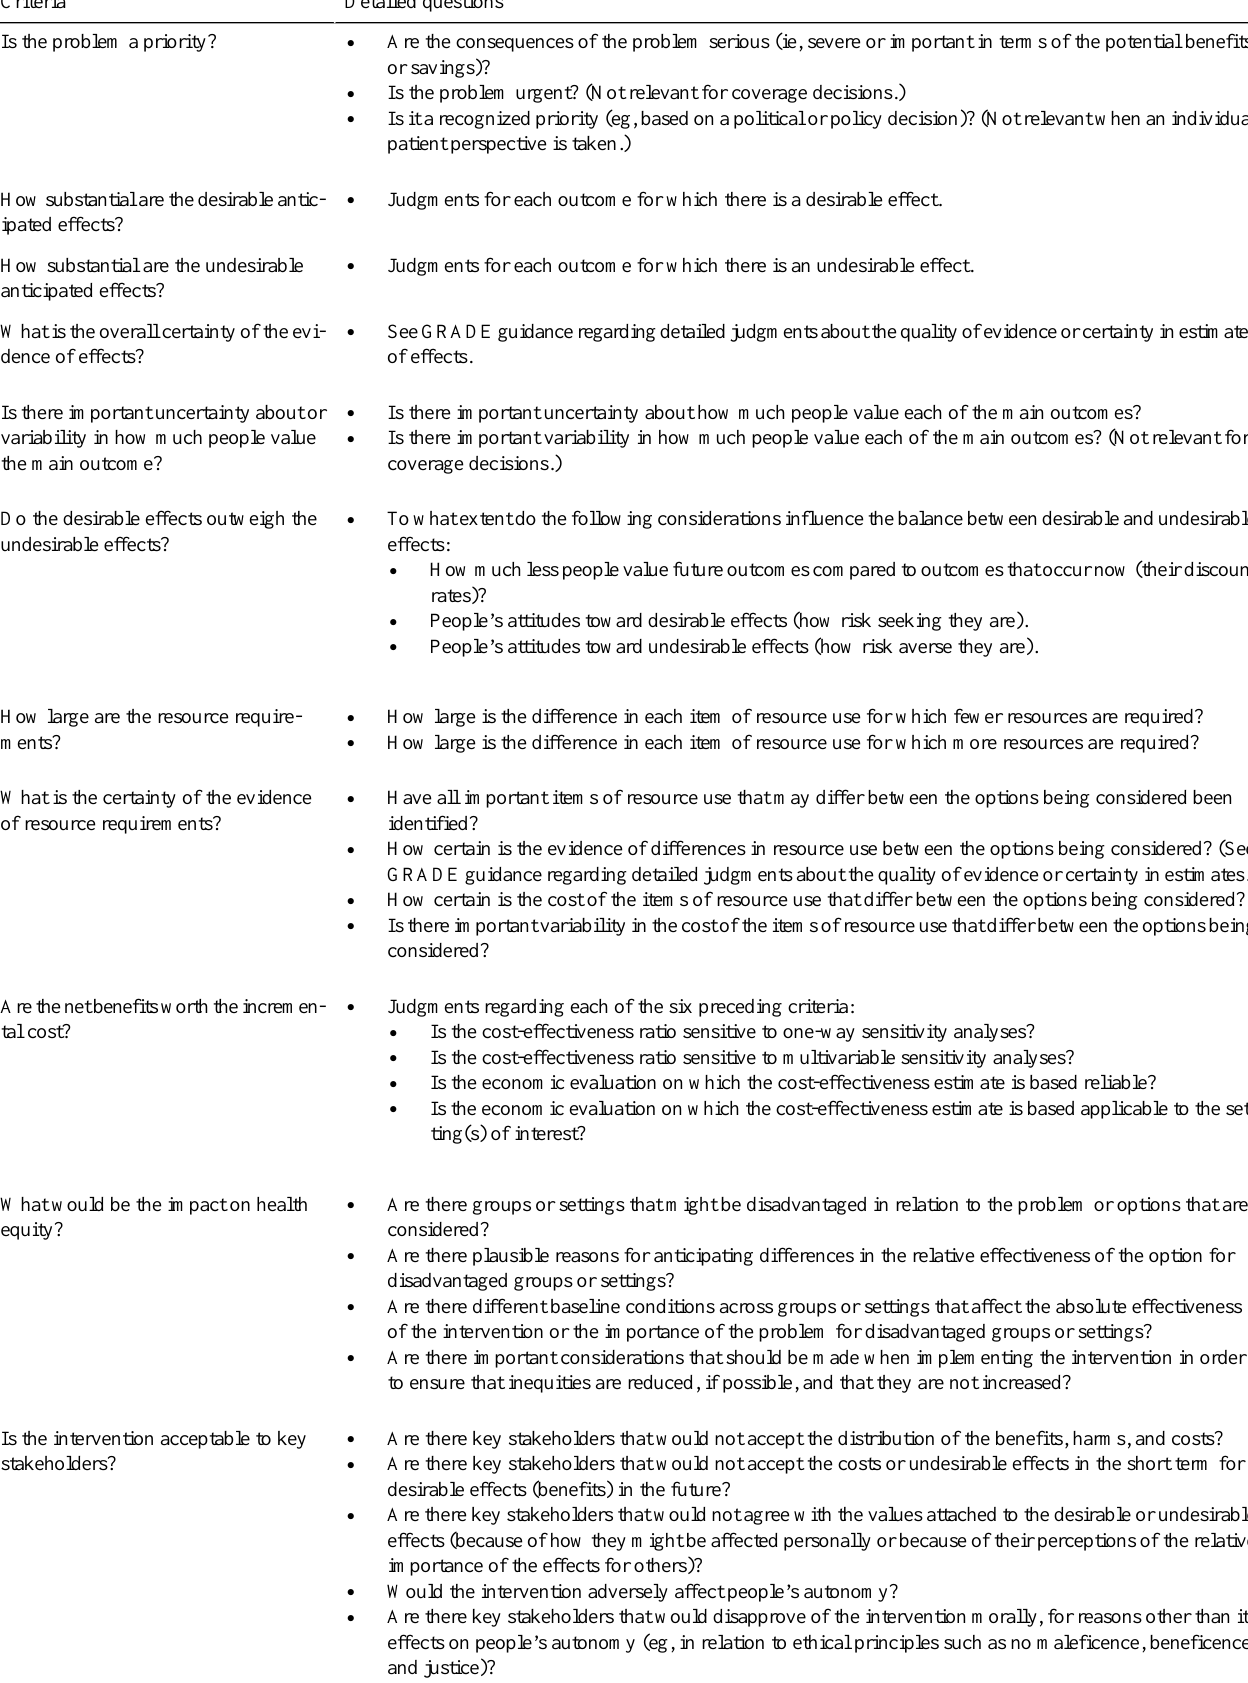
Table 2. GRADE EtD (Grading of Recommendations Assessment, Development and Evaluation Evidence to Decision) criteria of decision making for health system and public health decisions